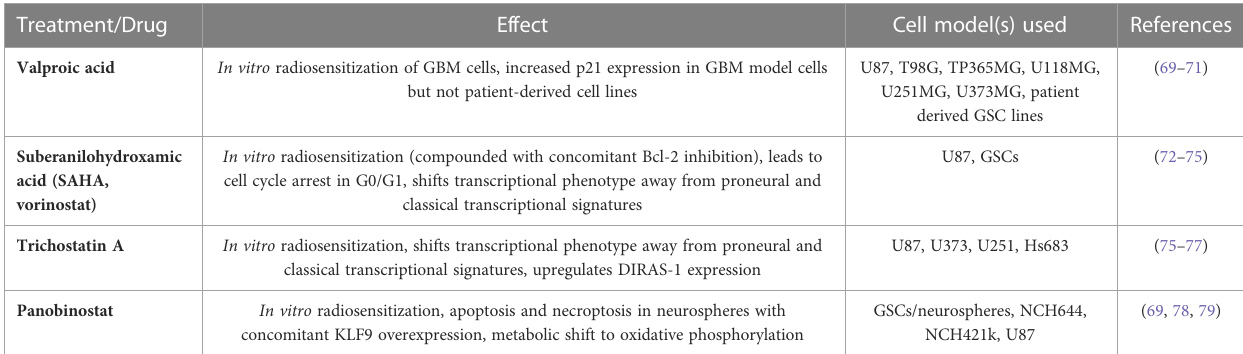
Table 2. In addition to its anticonvulsant properties, valproic acid